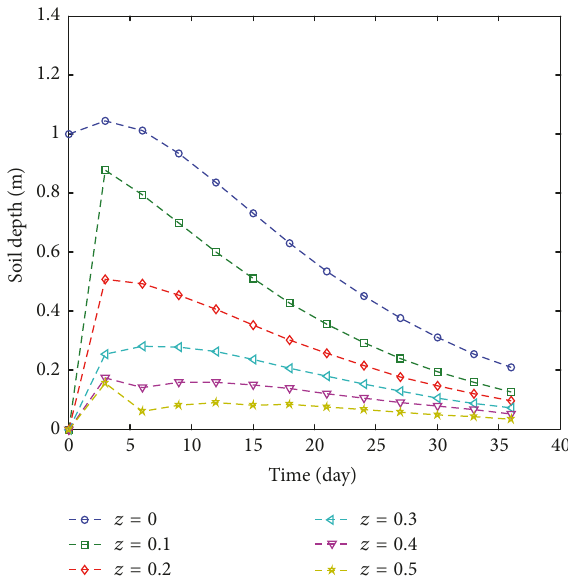
Figure 6: Simulated results of varying soil